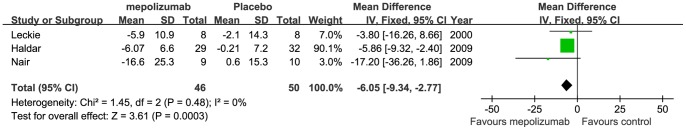
The effects of mepolizumab on sputum eosinophils (%).